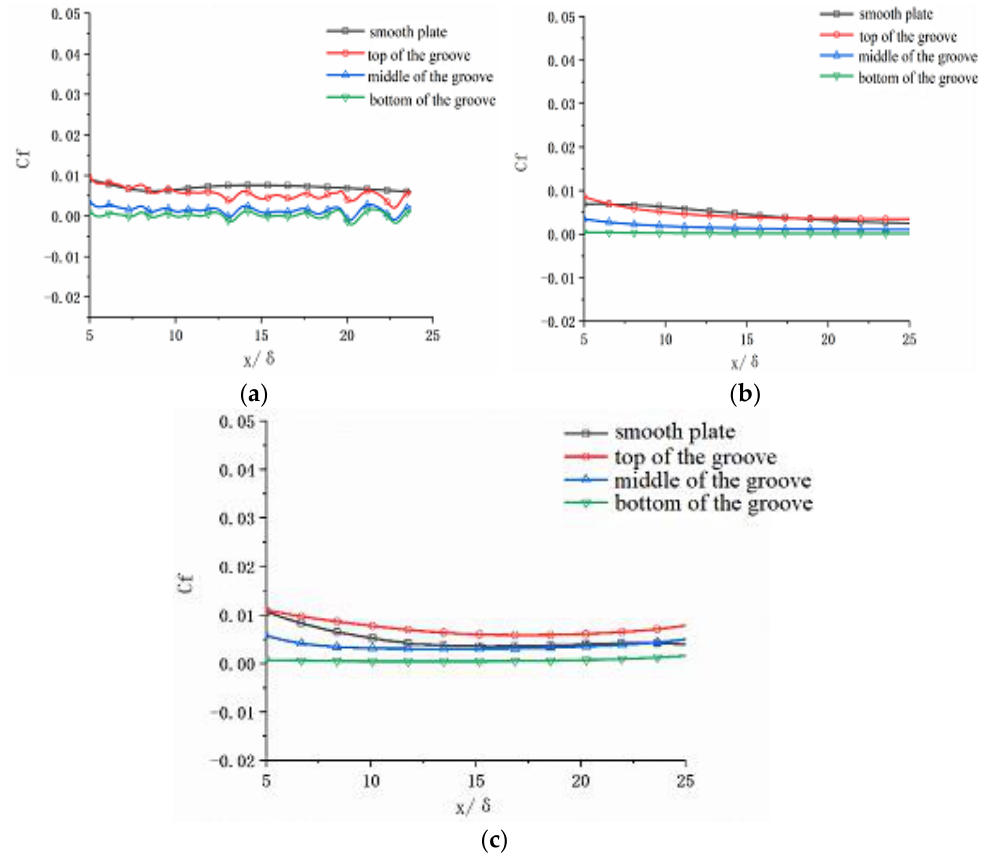
Figure 19. The shear stress coefficient distribution of triangular groove plate along the flow direction under different Mach numbers; ( a ) 0.3Ma; ( b ) 0.5Ma; and ( c ) 0.8Ma. under different Mach numbers; ( a ) 0.3 Ma; ( b ) 0.5Ma; and ( c ) 0.8